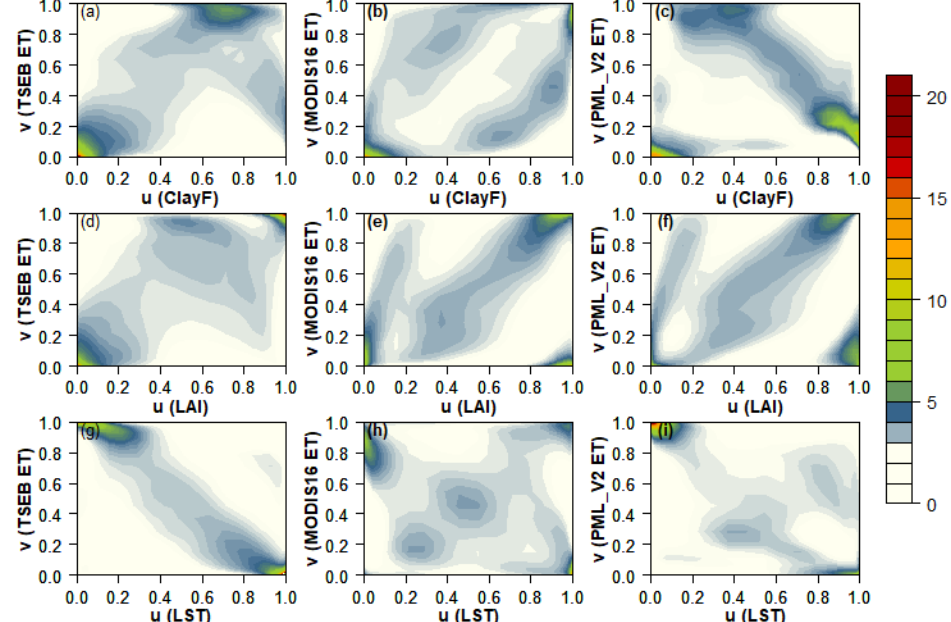
Figure A4. Same as in Figure A3, but for the land-surface variables of clay fraction ClayF (top panels), leaf area index LAI (middle panels), and land surface temperature LST (bottom panels). In all the panels ( a – i ), remote sensing ET (y-axis) are plotted against land-surface variables (x-axis).